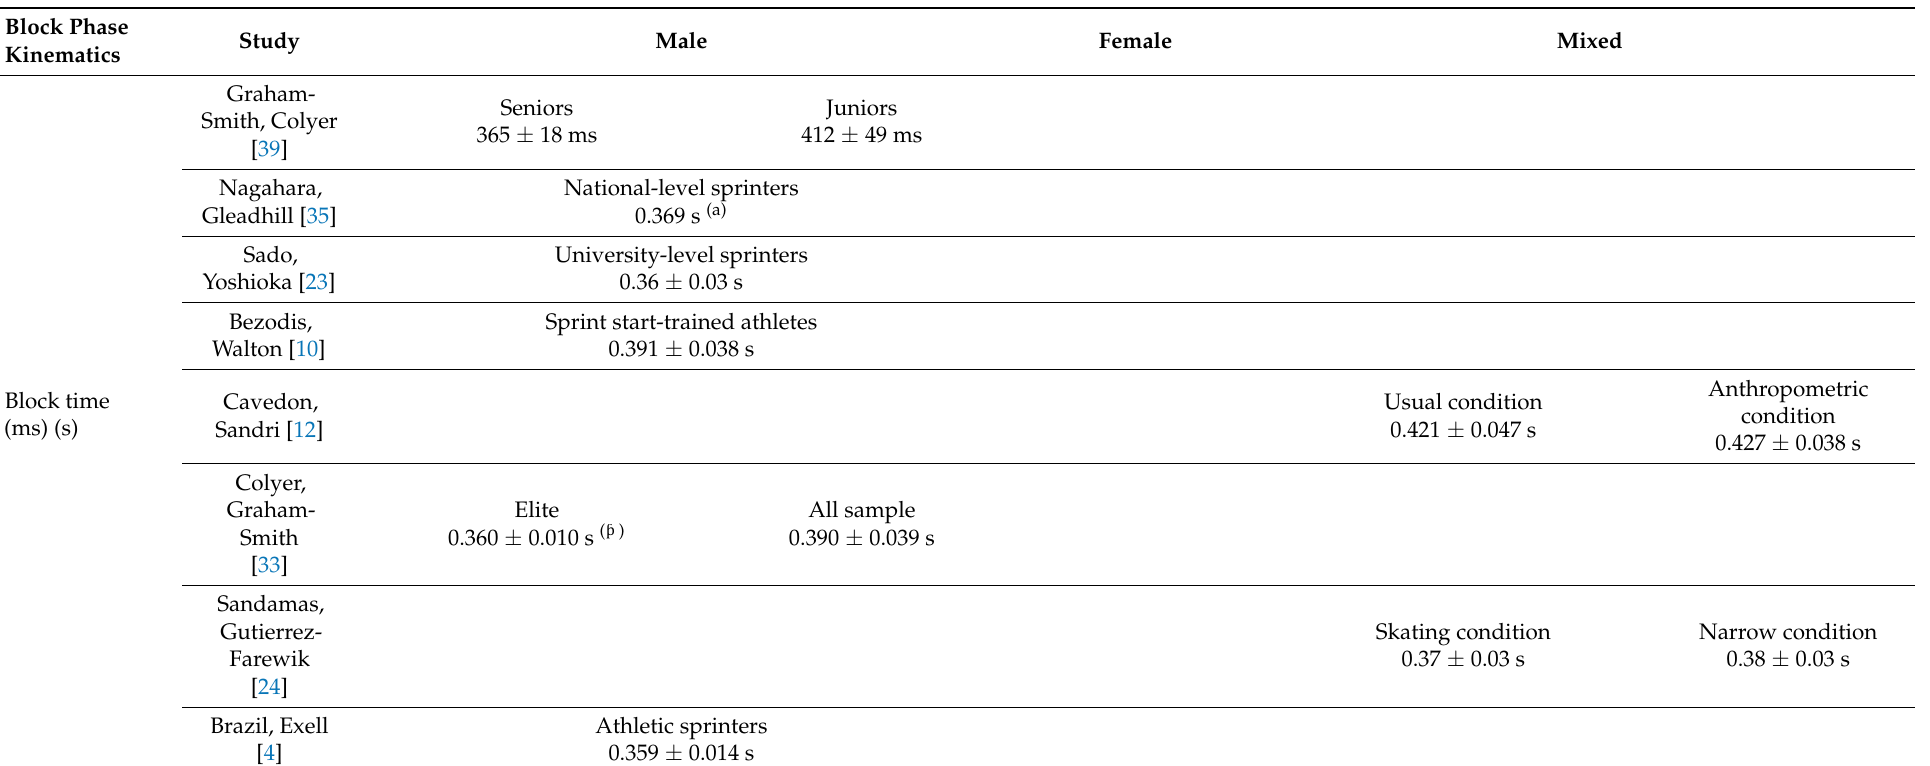
Table A2. Summary of the kinematic variables in the “Block Phase”. Data are the magnitude of the mean ± SD presented in the reviewed studies. Groups are male, female, and mixed (when authors joined data without discriminating by sex) sprinters. Studies are listed, in each variable, in reverse-chronological order, followed by alphabetically for studies published in the same year. Data, terms, conditions, and sprinters’ performance levels are presented according to the original authors. Statistical differences between groups are marked with asterisks (* p < 0.05; ** p < 0.01; *** p < 0.001; # Cohen’s d—large effect size (>0.8); § small effect size [0.2–0.6] of Ϯ adults; ƥ different clearly associated with average horizontal power produced across the block from descending phase— p < 0.05; ¥ significantly greater compared to the bunched start. significantly greater compared with either leg in the block phase).